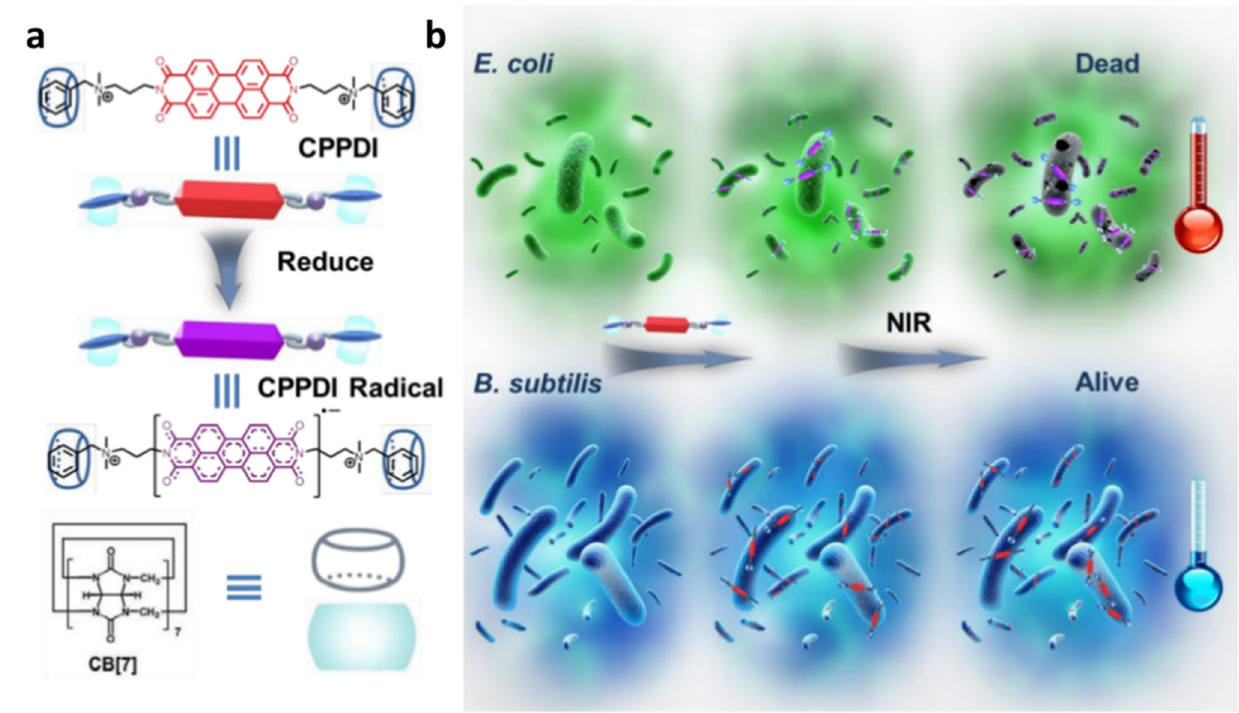
Figure 26. Diagram of ( a ) the chemical structures of CPPDI and CPPDI radical anions; ( b ) photothermal therapy for CPPDI with high selectivity towards E. coli over B. subtilis (reproduced with permission of John Wiley & Sons, Inc. from ref. [104]).